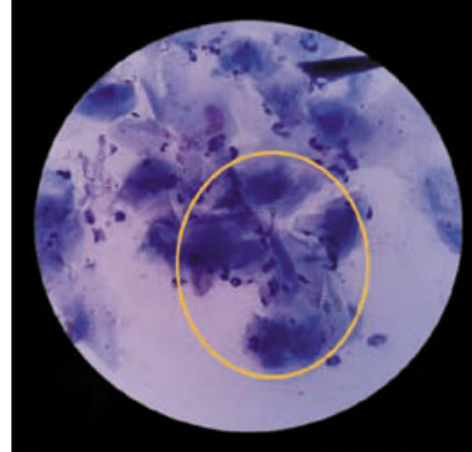
Fig. 5. Adherence of yeast to canine corneocyte Fig. 4. Ear swab with malassezia yeast, and